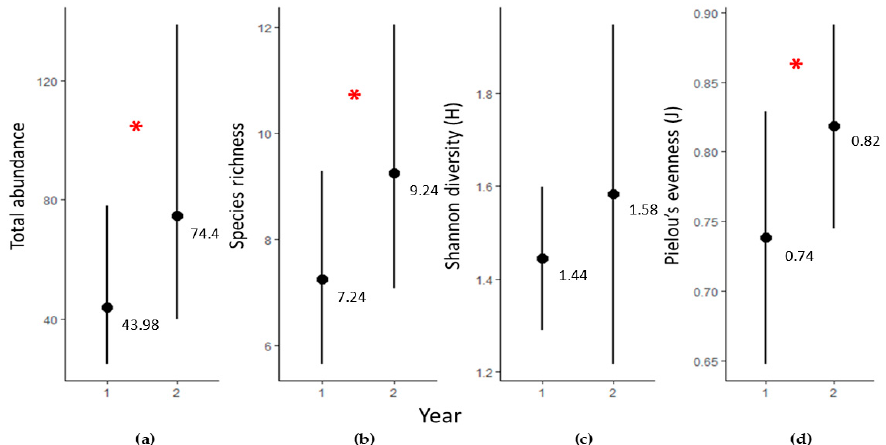
Figure 2. Temporal variation (fitted values ± 95% confidence intervals) in: ( a ) the total abundance (number of individuals/0.1 m 3 of artificial structure); ( b ) species richness (number of taxa/0.1m 3 of artificial structure); ( c ) Shannon diversity; and ( d ) Pielou’s evenness of invertebrate assemblages in artificial Dock Biohut structures within Year 1 and Year 2 since installation. Significant differences between time periods of each metric are indicated with asterisks (red * indicates p ≤ 0.05). The taxonomic composition of invertebrate assemblages varied between Year 1 and Year 2. Non-metric MDS ordination showed distinct clusters between Year 1 and Year 2 (Figure 3). For both Le Bacar è s and Port-Vendres, the Year 2 data were closer to each other than for the Year 1. The stress value (0.07, 0.1, and 0.08, respectively) provides a good representation of our data in reduced dimensions. PERMANOVA (F (1,40) = 3.569; p < 0.05) analysis revealed variation in taxonomic composition of invertebrate assemblages from Year 1 to Year 2 (Figure 3). However, PERMDISP analysis showed significant differences in the mean distance from centroids among the groups (F (5,40) = 11.099; p < 0.001), indicating that results from PERMANOVA should be interpreted with